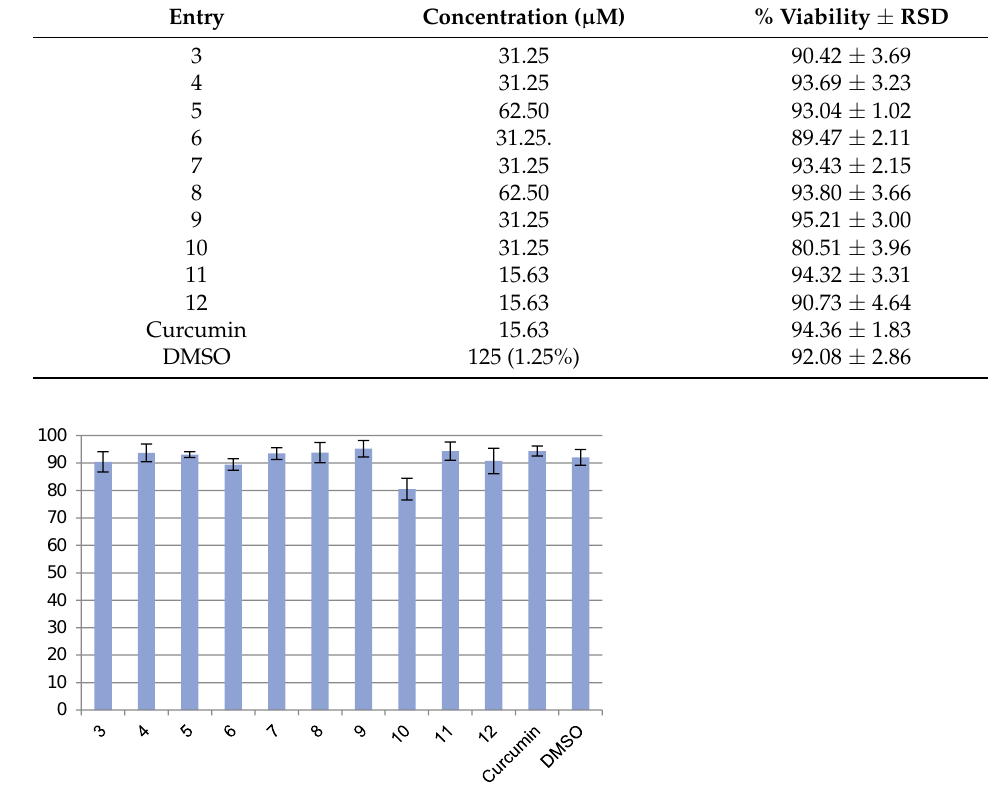
Figure 1. Cytotoxicity of each produced substance, curcumin, and DMSO on SK-N-SH neuroblastoma cells at a concentration of 31.25, 31.25, 62.5, 31.25, 31.25, 62.5, 31.25, 31.25, 15.63, 15.63, and 15.63 µM and 1.25% v/v , respectively. The percentages of relative cell viability (mean ± RSD) were calculated at 24 h using MTT assays ( n = 6) (Y = % viability, X = synthesized compound). Table 3. Neuroprotective effect on SK-N-SH neuroblastoma cells of test compounds at the IC 50 value, except compounds 9 and 10 , against Aβ induced damage.